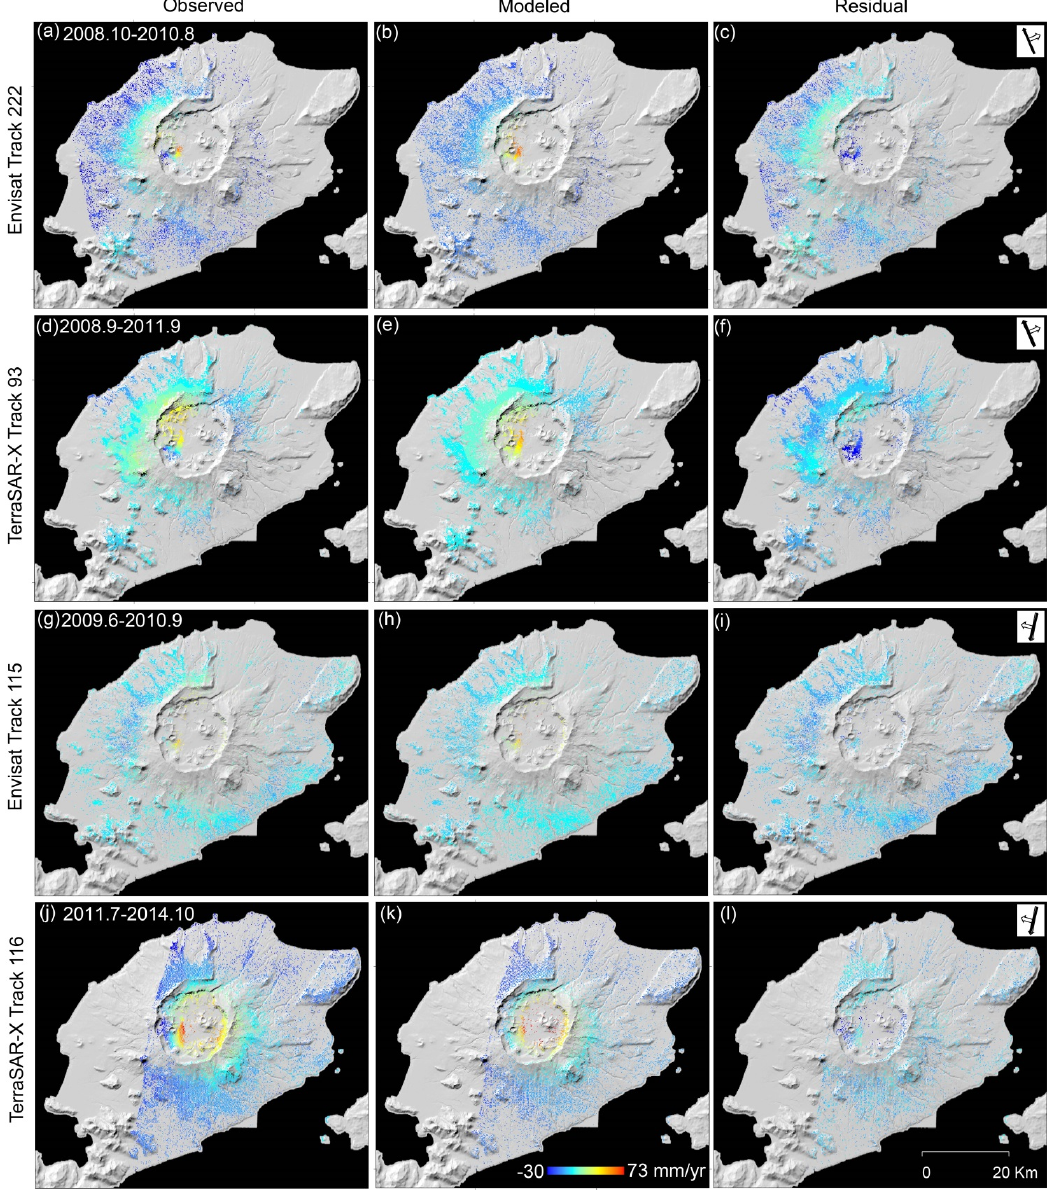
Figure 4. Observed ( Left ), modeled ( Middle ), and residual ( Right ) average LOS deformation maps for the four independent tracks of InSAR data during September 2008 to October 2014 (Table 1). Satellite flight direction and radar look direction are labelled. The cold colors (blue to yellow) represent subsidence, i.e. , incremental displacement away from the satellite, to low-rate uplift, i.e. , displacement towards the satellite, and the hot-colored points show high-rate uplift. The color scale is the same for all images.